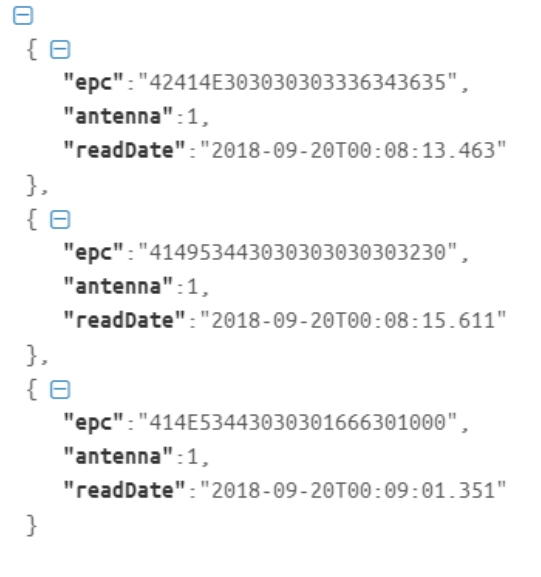
Figure 5. JSON file of the Read microservice response.